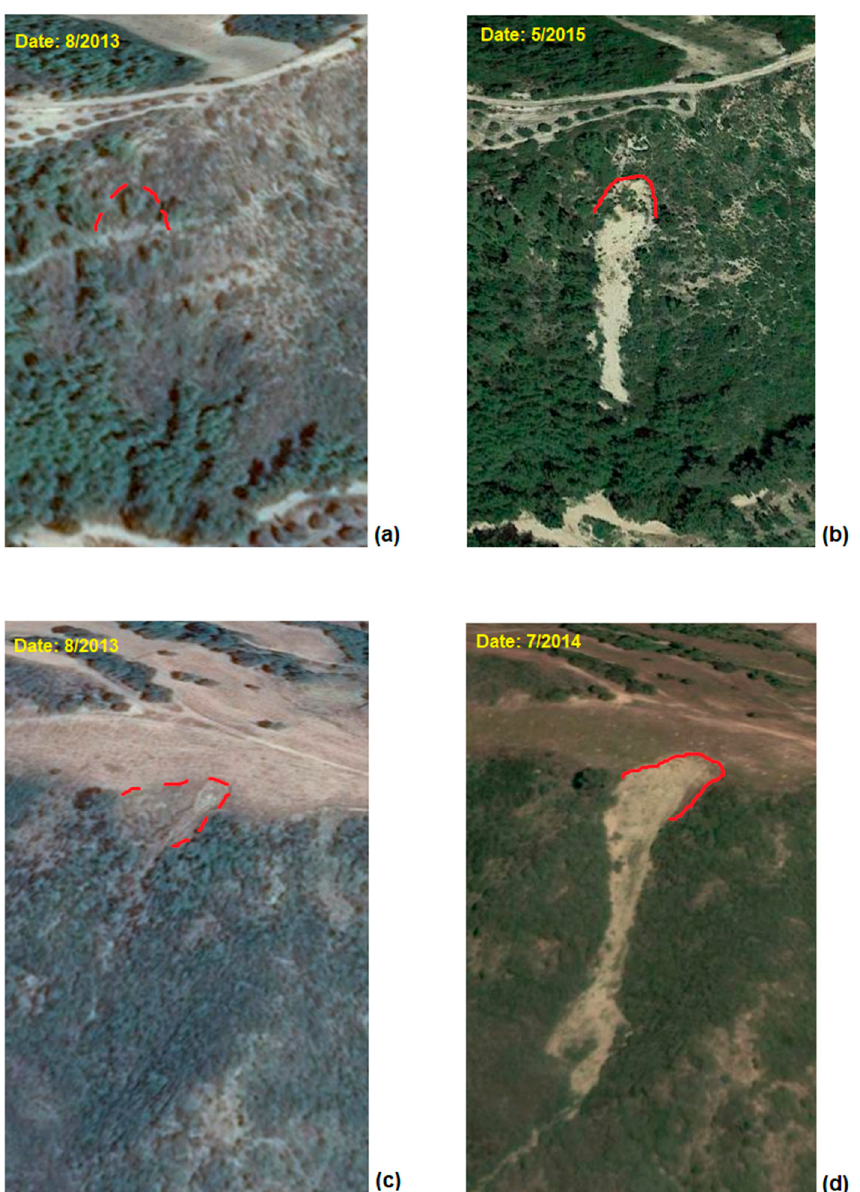
Figure 2. Multi-temporal Google Earth images: ( a , c ) before the landslides; ( b , d ) after the landslides. The red dashed lines indicate the location of the landslide before it happened, and the red solid line shows the scar of the landslide after it occurred.